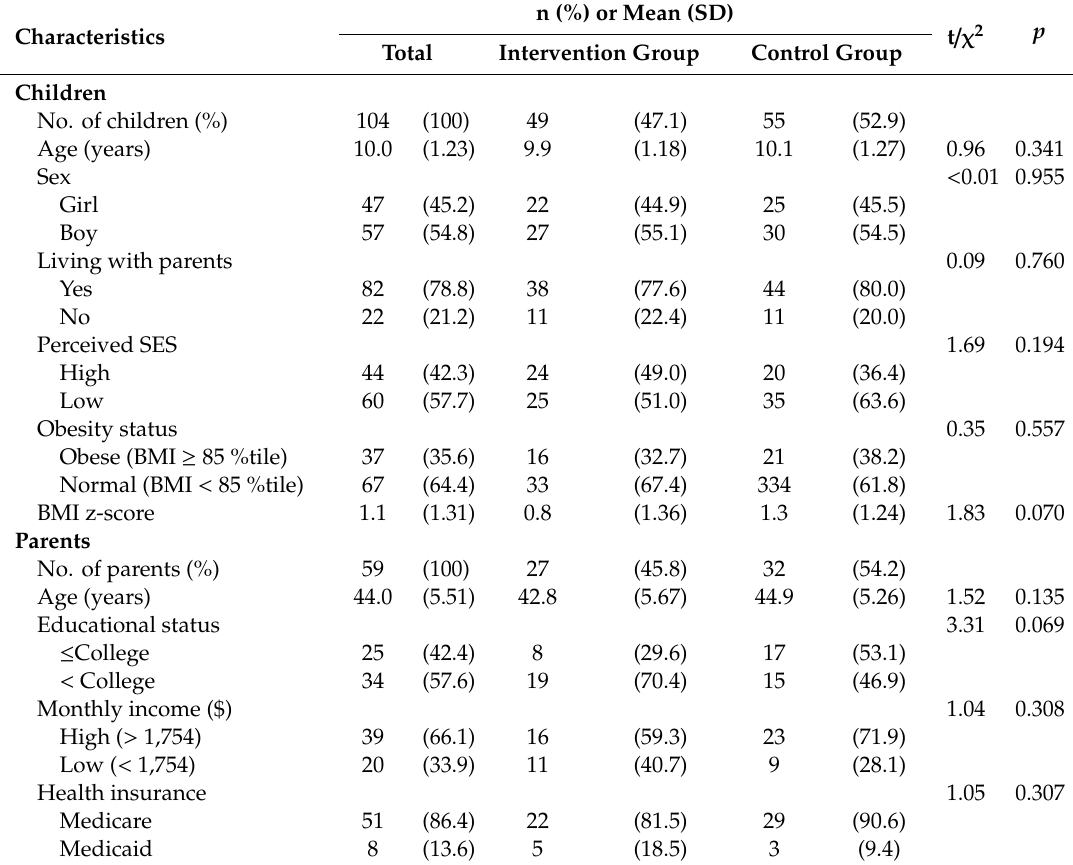
Table 2. Participants’ baseline general